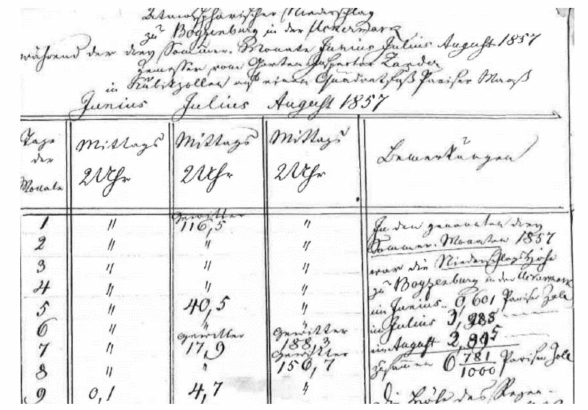
Figure 16. Hand-written protocol (in Sütterlin letters) of rainfall depths. The columns indicate the day of the month at months June, July, and August 1857 and the amount of rainfall at 2 pm